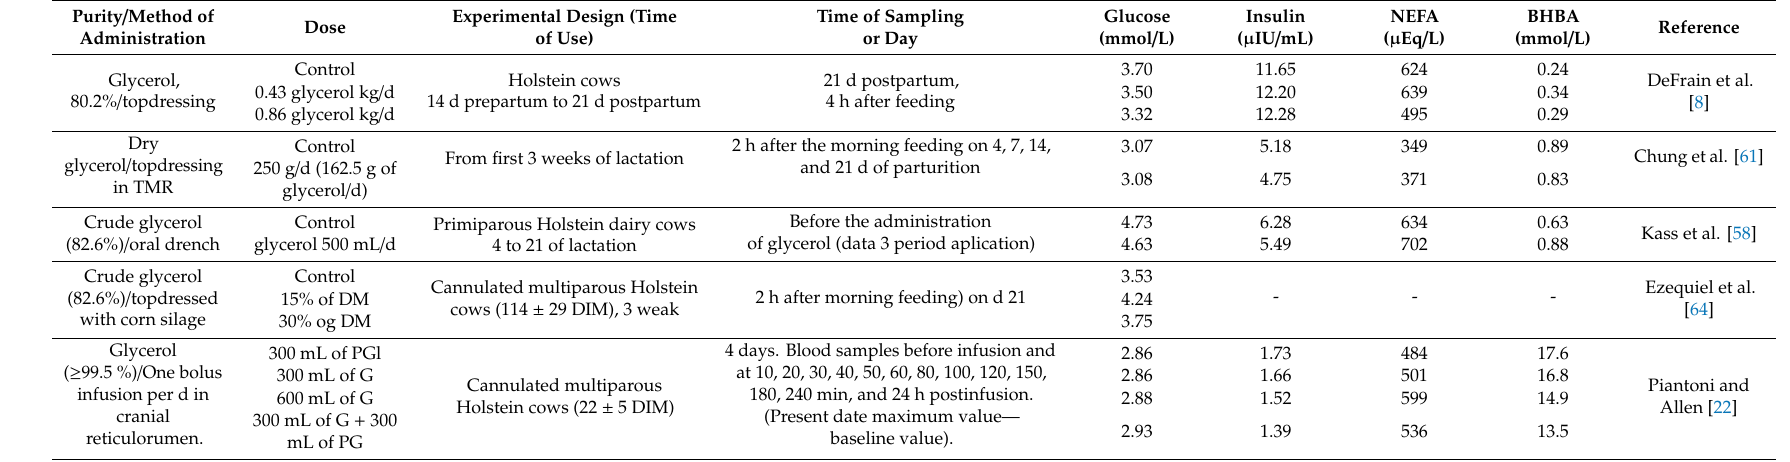
Table 2. The e ff ect of gycerol administration on concentrations of blood glucose, insulin, non-esterified fatty acids (NEFA), and β -hydroxybutyrate (BHBA) in